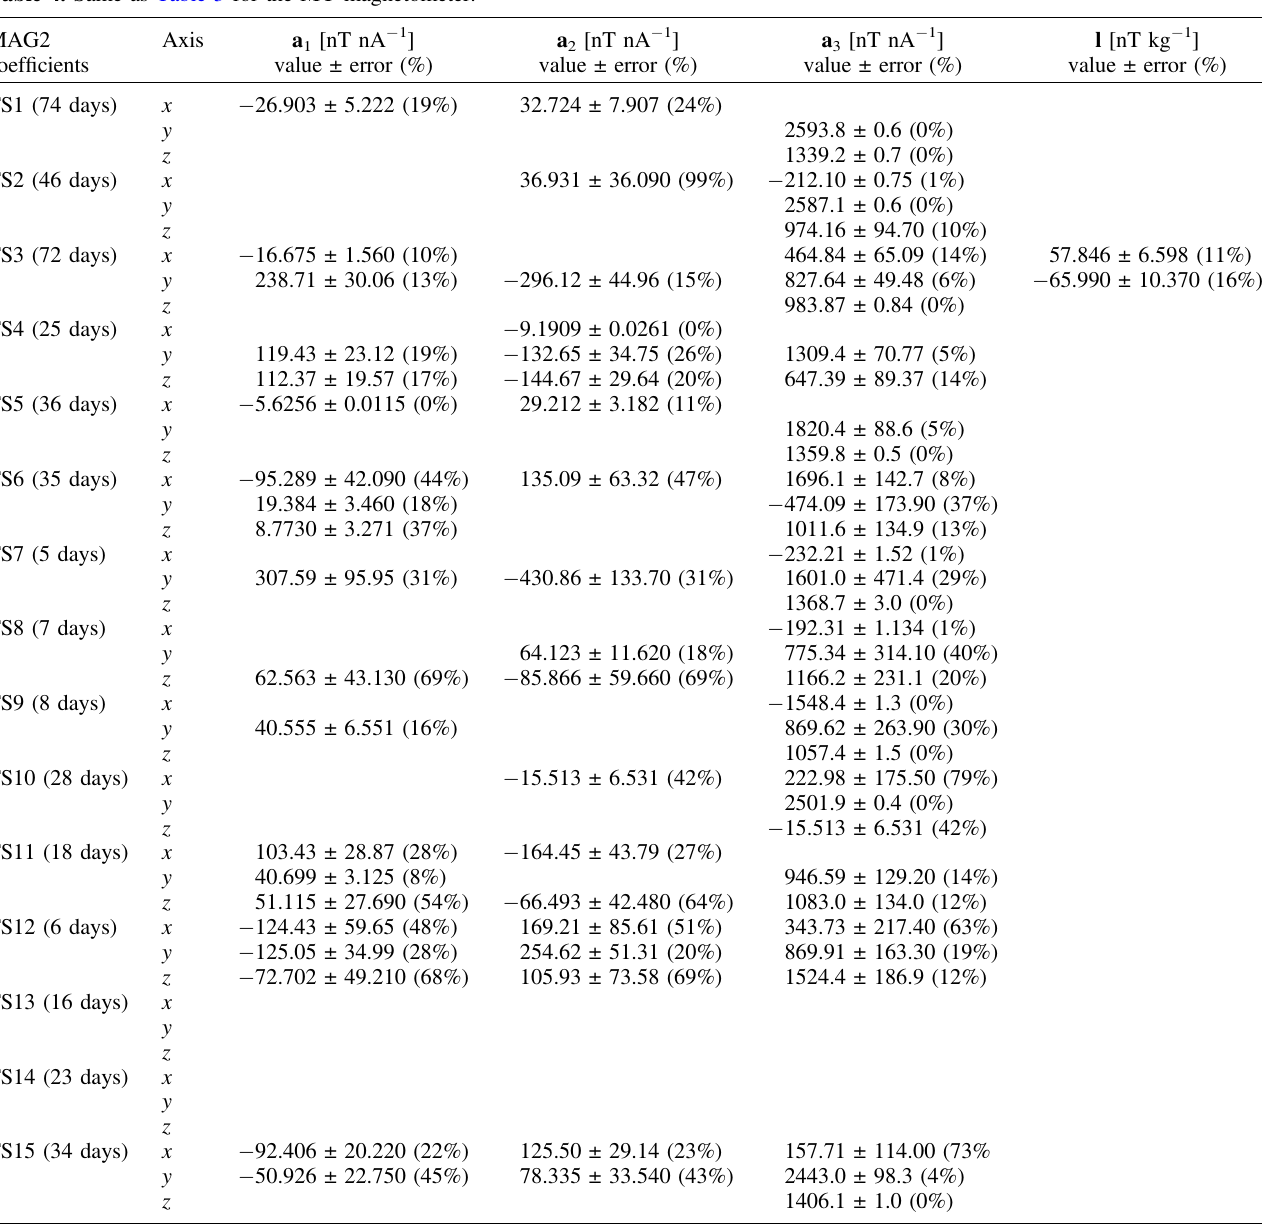
Table 4. Same as Table 3 for the MY magnetometer. MAG2 coef fi